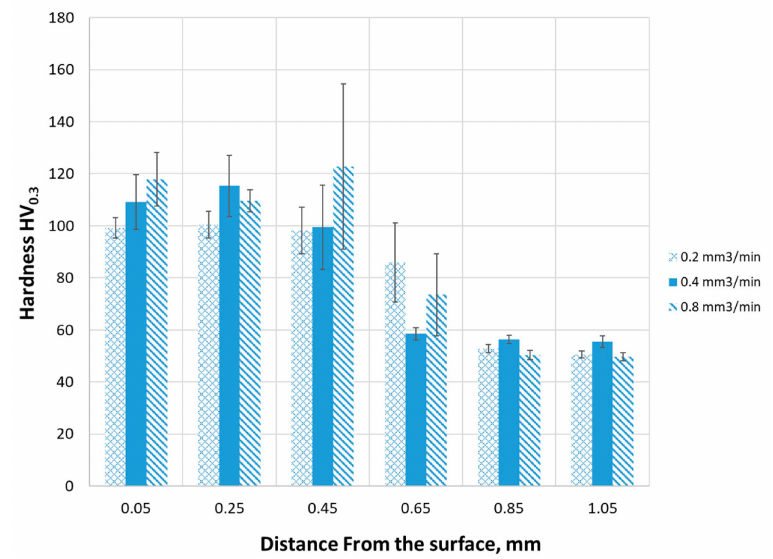
Figure 14. Change in hardness in distance from the coating